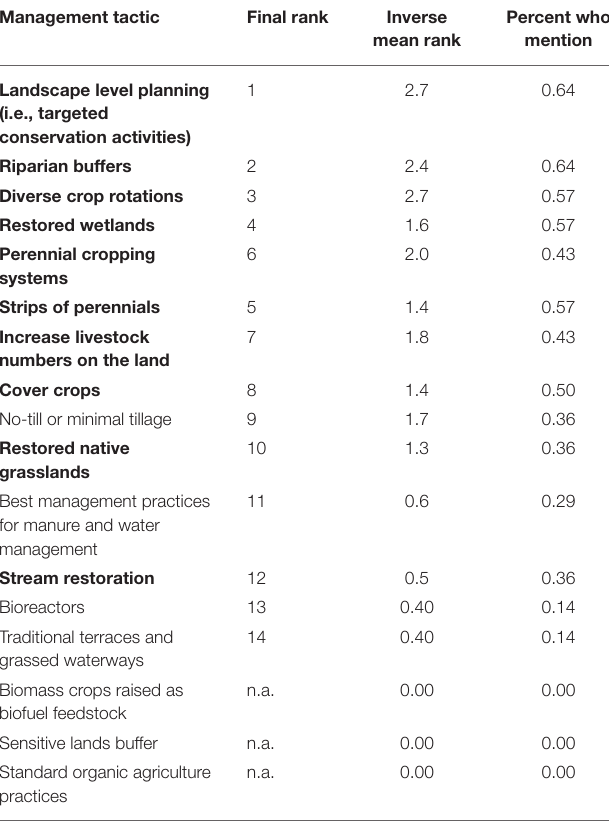
TABLE 5 | Land management practices important for maintaining and enhancing ecosystem services from agricultural lands in Iowa, developed from participant ranking in the second round of a Delphi